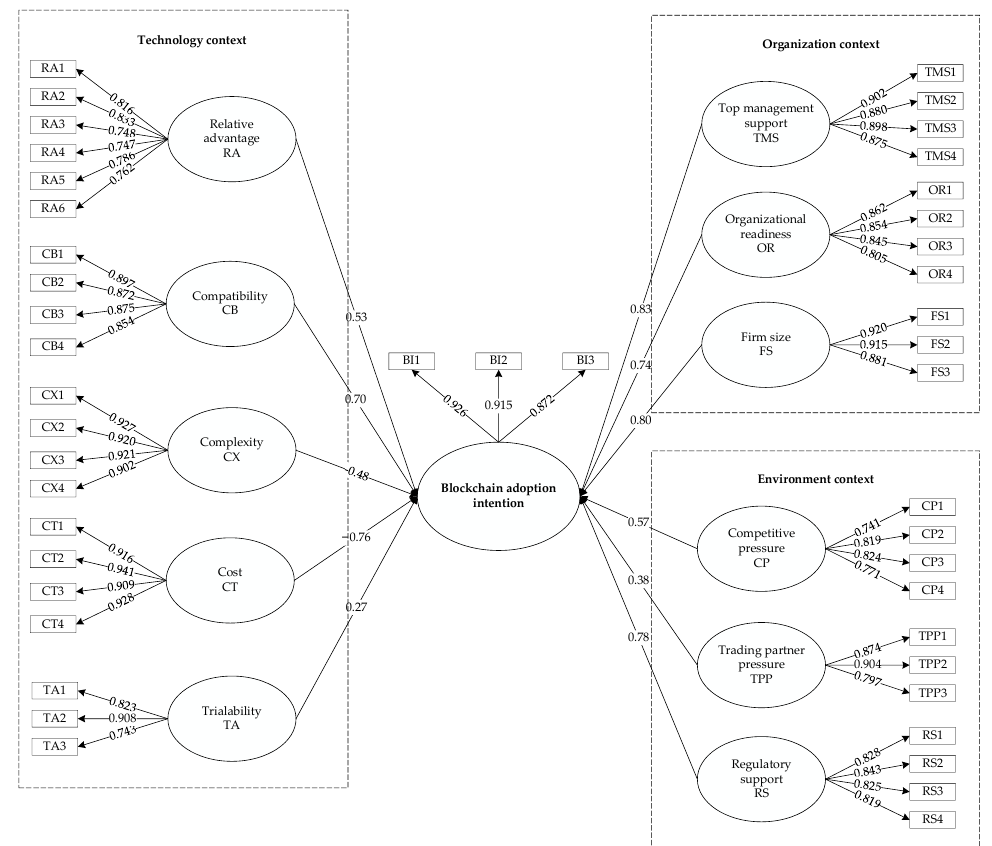
Figure 2. Fornell and Larcker criterion for discriminant validity results.